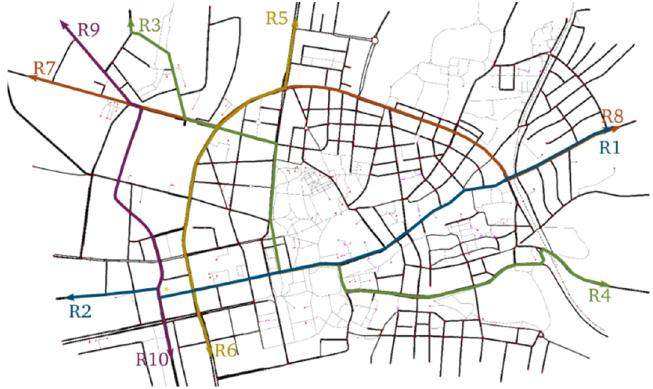
Figure 11. Test routes for the simulative experiments.